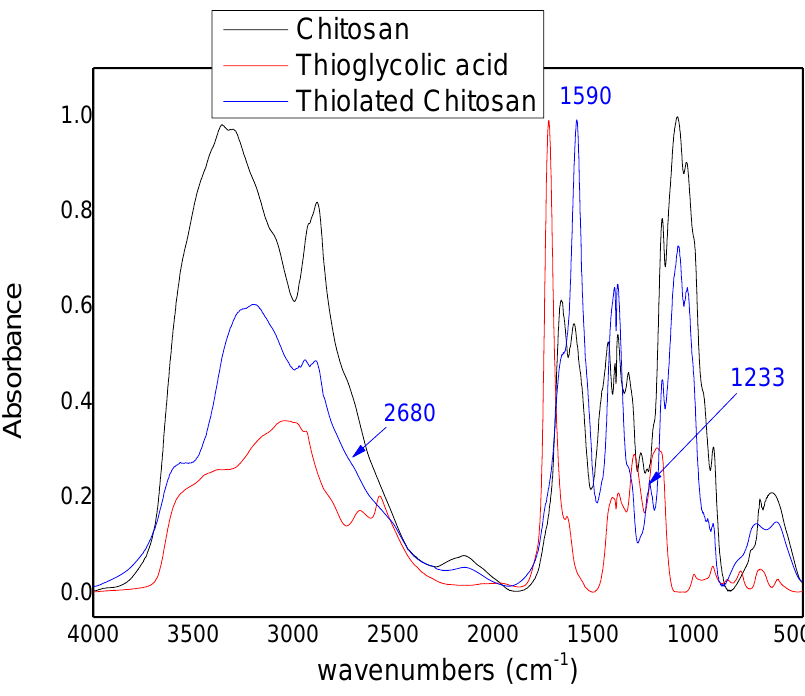
Figure 1. FTIR spectra of chitosan, thioglycolic acid, and thiolated chitosan.